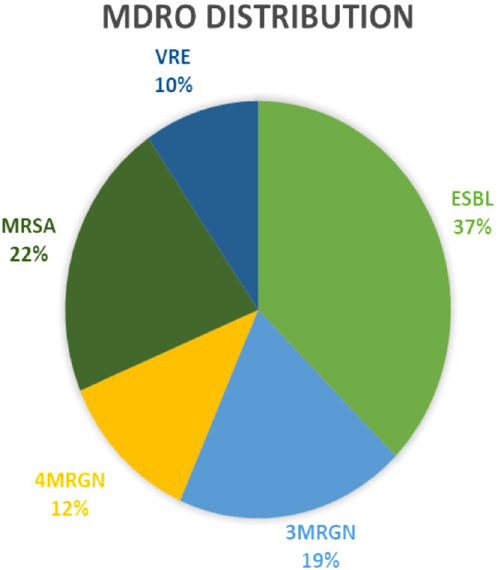
Figure 1. MDRO distribution. MDRO multi drug resistant organism, distribution in the subgroup. ESBL extended-spectrum beta-lactamase producing bacteria ( E.coli, K. pneumoniae, K. oxytoca ), MRSA methicillin- resistant Staphylococcus aureus , 3 MDRGN multidrug resistant Gram-negative bacteria ( E. coli, K. pneumoniae, P. aeruginosa ), 4 MDRGN multidrug resistant Gram-negative bacteria ( A. baumanii, K. pneumoniae, P. aeruginosa, E. aerogenes ), VRE vancomycin-resistant Enterococcus . 4 patients with multiple infections (2 patients 3 MDRGN + VRE, 1 patient MRSA + ESBL, 1 patient VRE + 3MDRGN) resulting in 83 positive detections in